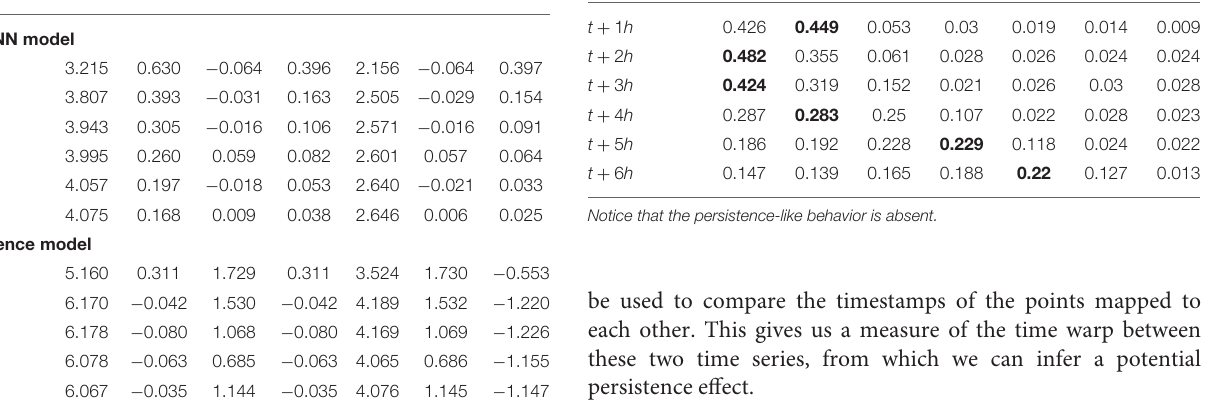
TABLE 5 | Evaluation of the LSTM-NN model and the persistence model with the metrics from section 2.3.2 when forecasting 1 Dst. Forecasting horizon